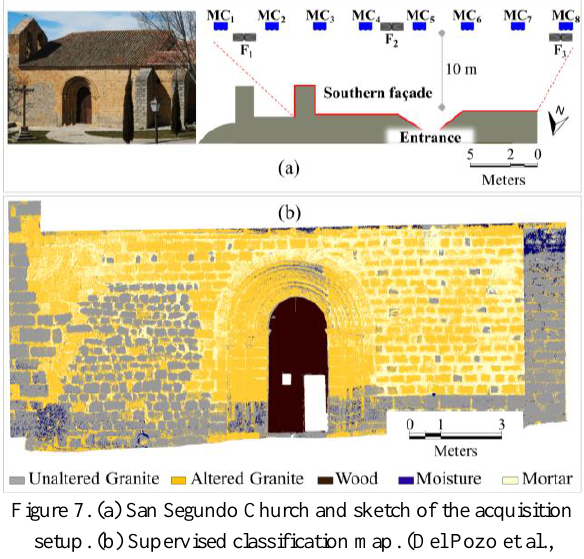
Figure 7. (a) San Segundo Church and sketch of the acquisition setup. (b) Supervised classification map. (Del Pozo et al.,